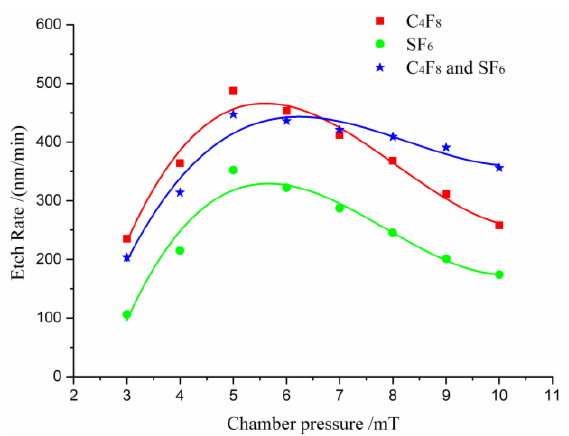
Figure 7. The relationship between the chamber pressure and etch rate.